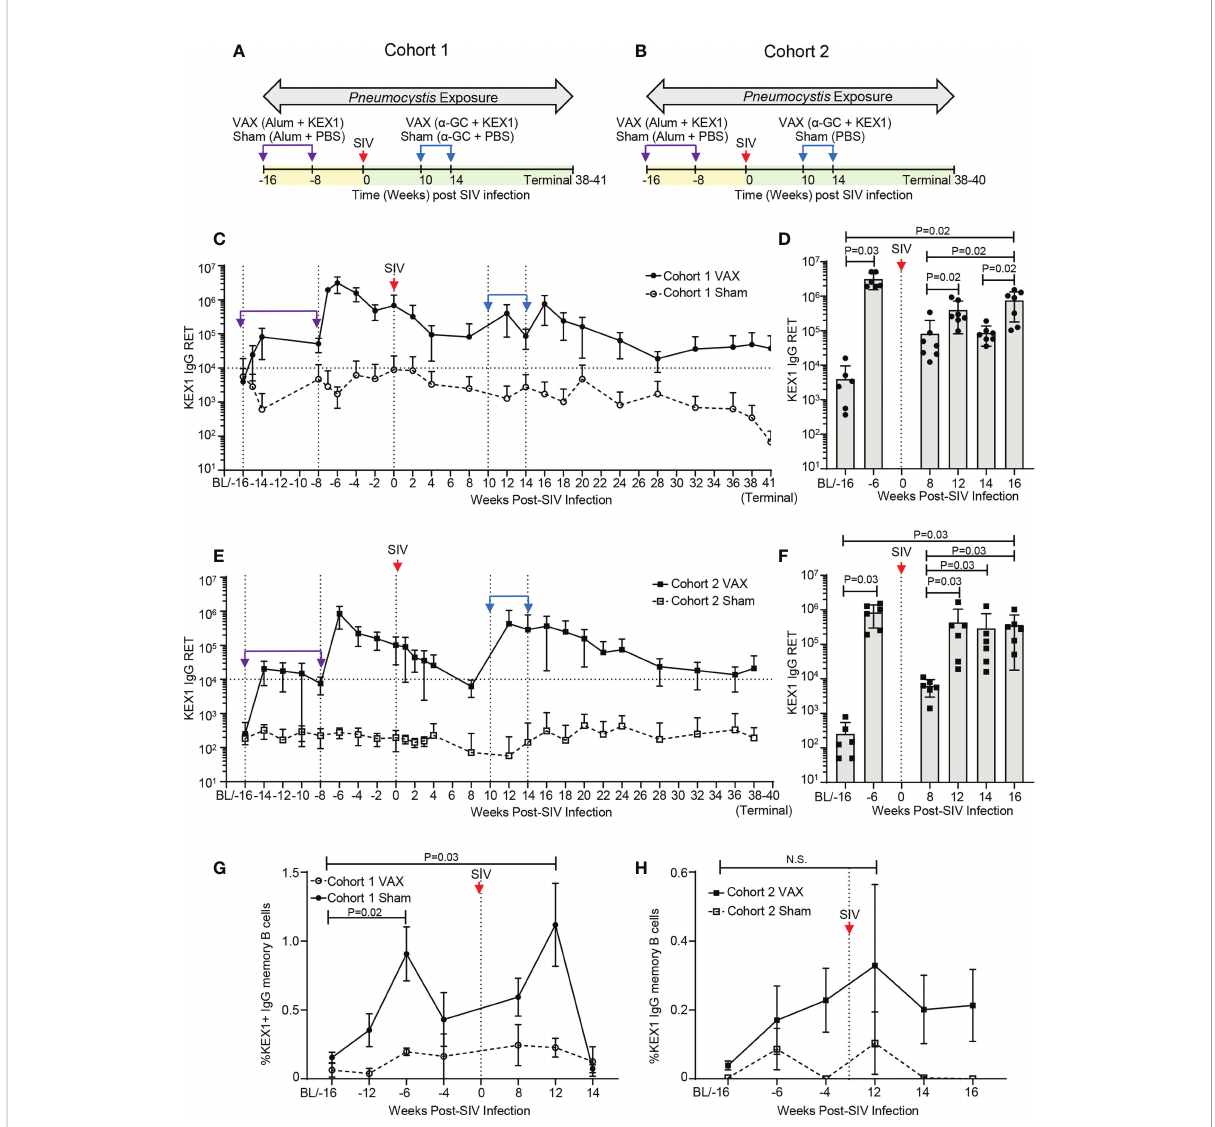
FIGURE 1 KEX1-speci fi c humoral responses in rhesus macaques following vaccination with alum+KEX1 prior to SIV infection and boosting with a -GC +KEX1 in the early chronic phase of infection. Schematic of immunization, SIV infection, and Pneumocystis co-infection of rhesus macaques in (A) Cohort 1 and (B) Cohort 2. Vertical dashed lines indicate vaccination timepoints. Purple arrows and indicate immunizations with in healthy macaques with alum+KEX1 prior to SIV infection. Blue arrows indicate therapeutic boosting with a -GC+KEX1 at 10 and 14 weeks post-infection. Kinetics of plasma KEX1-speci fi c reciprocal endpoint titers (KEX1+ IgG RET) in (C, D) Cohort 1 and (E, F) Cohort 2. Horizontal dashed lines at 10,000 RET indicate the correlate of protection. (D, F) Peak plasma titers following alum+KEX1 immunization and a -GC+KEX1 boosting. (G, H) Kinetics of KEX1-speci fi c memory B cell responses (%KEX1 IgG Memory B cells) Not signi fi cant (N.S.). (D, F, G, H) Wilcoxon signed rank test were performed to compare indicated timepoints within the VAX group. Data represents the mean ±